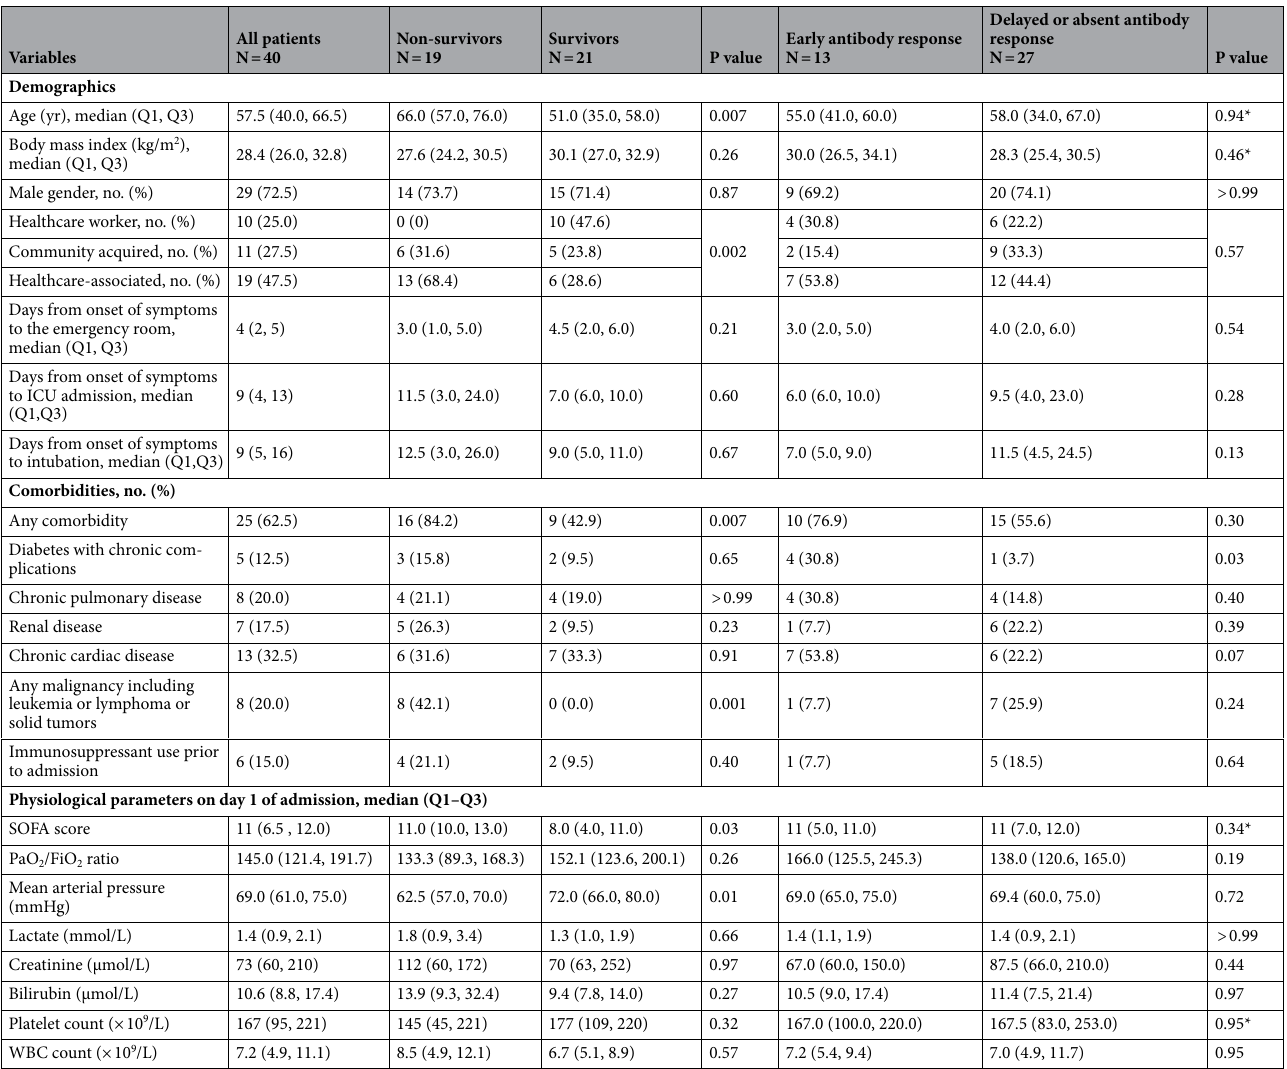
Table 1. Comparison of baseline characteristics and physiologic parameters of patients with Middle East respiratory syndrome (MERS) between non-survivors, survivors and between those with early antibody response (day 1–3) and delayed or absent antibody response. SOFA: Sequential Organ Failure Assessment; PaO 2 /FiO 2 ratio: the ratio of the partial pressure of oxygen to the fraction of inspired oxygen; Q1: first quartile, Q3: third quartile; For all percentages, the denominator is the total number of subjects in the group. For continuous variables, Mann–Whitney U test is used to calculate the p-value except for p values labeled with * indicating the use of Students t test. For categorical variables, Fisher’s exact test is used to calculate the